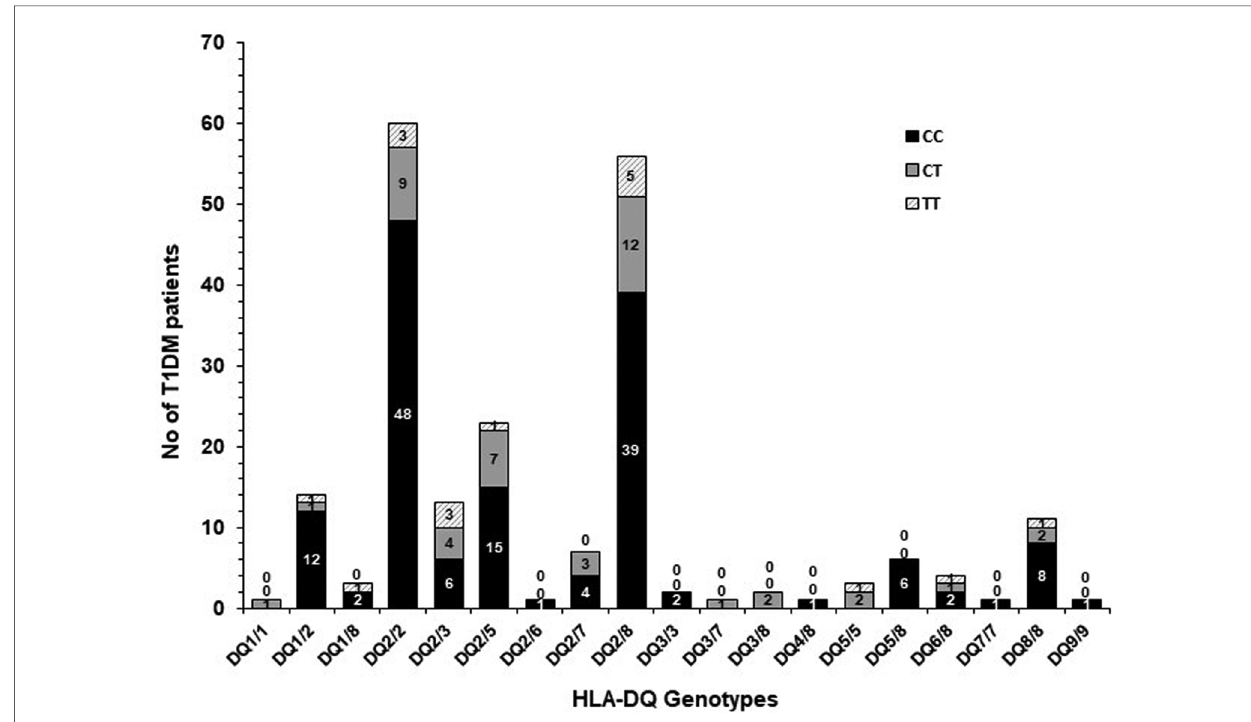
FIGURE 3 Co-inheritance of IL4 gene – C590T polymorphism genotypes with HLA-DQ genotypes in Kuwaiti T1DM patients. The shaded bars show the co- inheritance with various HLA-DQ genotypes.